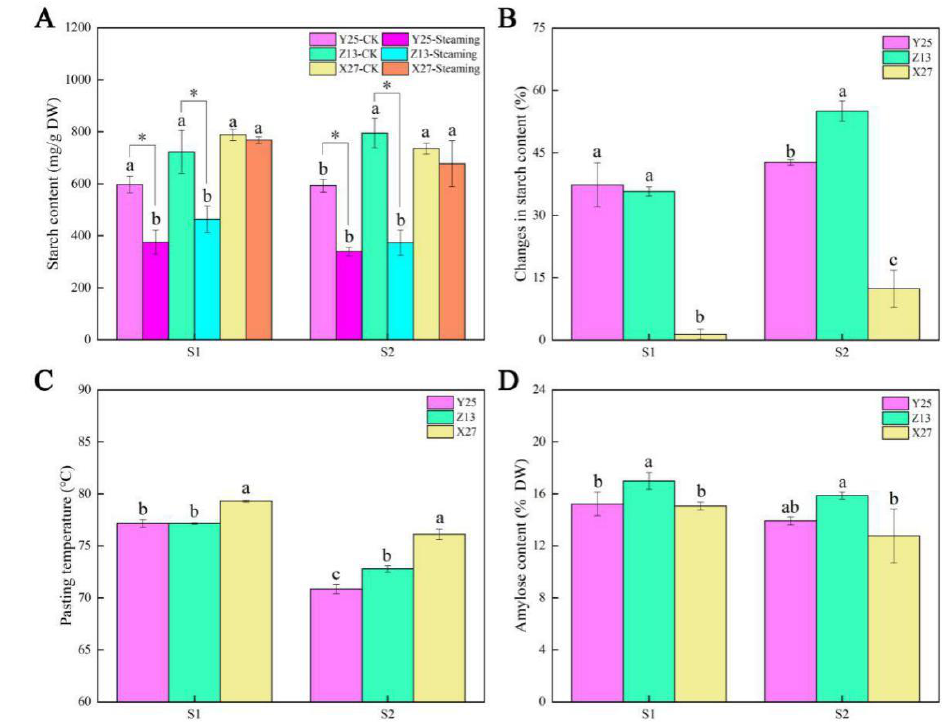
Figure 3. ( A ) Starch content, amylopectin content, and gelatinization temperature of the samples at 90 d and 130 d; ( B ) The changes of starch content in sweetpotato before and after steaming; ( C ) Changes in gelatinization temperature of sweetpotato starch; ( D ) Amylose content of sweetpotato. The SE of three biological repetitions is shown as an error bar. Bars not sharing a common letter differ ( p < 0.05) by one-way ANOVA and Tukey’s multiple comparison test. Asterisks indicate statistical differences between CK and steaming values ( p < 0.05, Student’s t-test).